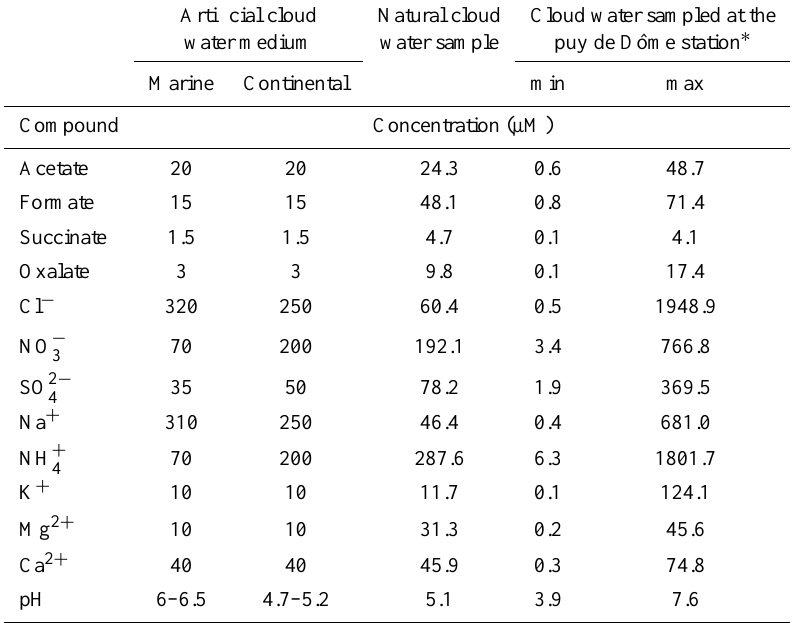
Table 1. Chemical composition of the artificial cloud water media and of the natural cloud water sample used for incubation experiments, and range of values observed in natural cloud water collected at the puy de Dˆome station.